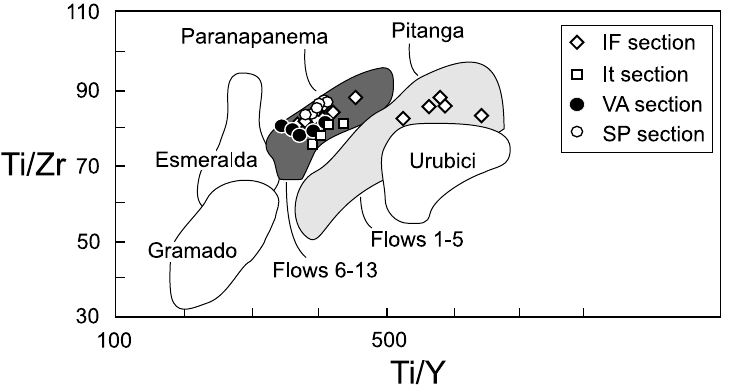
Fig. 6 – Ti/Y versus Ti/Zr diagram, showing the classification of samples from Vista Alegre region in the magma types of the Paraná volcanic province (after Peate